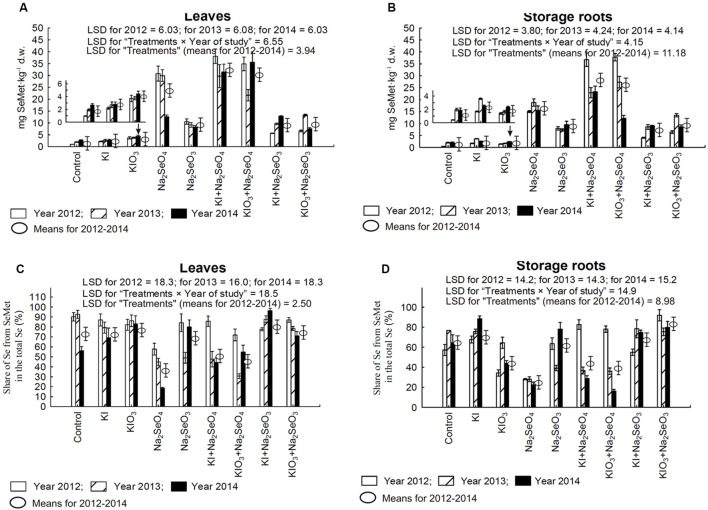
Selenomethionine (SeMet) concentration in leaves (A) and storage roots (B) as well as the percentage of total selenium present in SeMet for carrot leaves (C) and storage roots (D) in the years 2012–2014, depending on varying fertilization with iodine and selenium. LSD, least significant difference, p < 0.05. Bars indicate standard error; (n = 4).